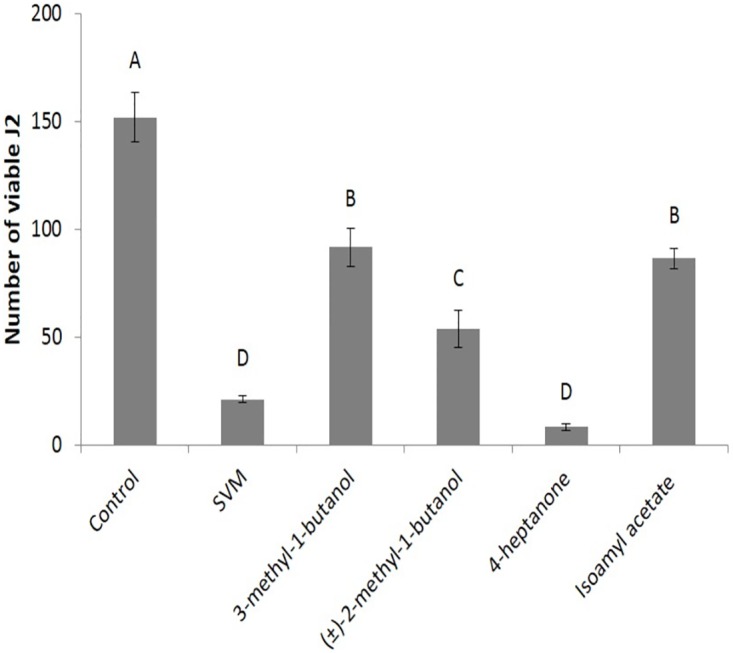
Effects of individual compounds on M. javanica J2 viability.J2s were separately exposed for 48 h to 3-methyl-1-butanol (0.2 mL, 1.84 mmole), (±)-2-methyl-1-butanol (0.2 mL, 1.86 mmole), 4-heptanone (0.4 mL, 2.86 mmole), isoamyl acetate (0.2 mL, 1.35 mmole), or to 1 mL combination thereof (SVM), before viable J2s were separated using 30 μm sieves. The numbers on the y-axis represent the numbers (mean ± SE) of viable J2s counted following the incubation. There were 7–10 repetitions, each using 300 J2s. The results were subjected to analysis of variance followed by the Tukey-Kramer multiple comparison test; different letters above the bars indicate a significant difference between samples at P ≤ 0.05. The experiment was independently repeated three times, each time with similar results.